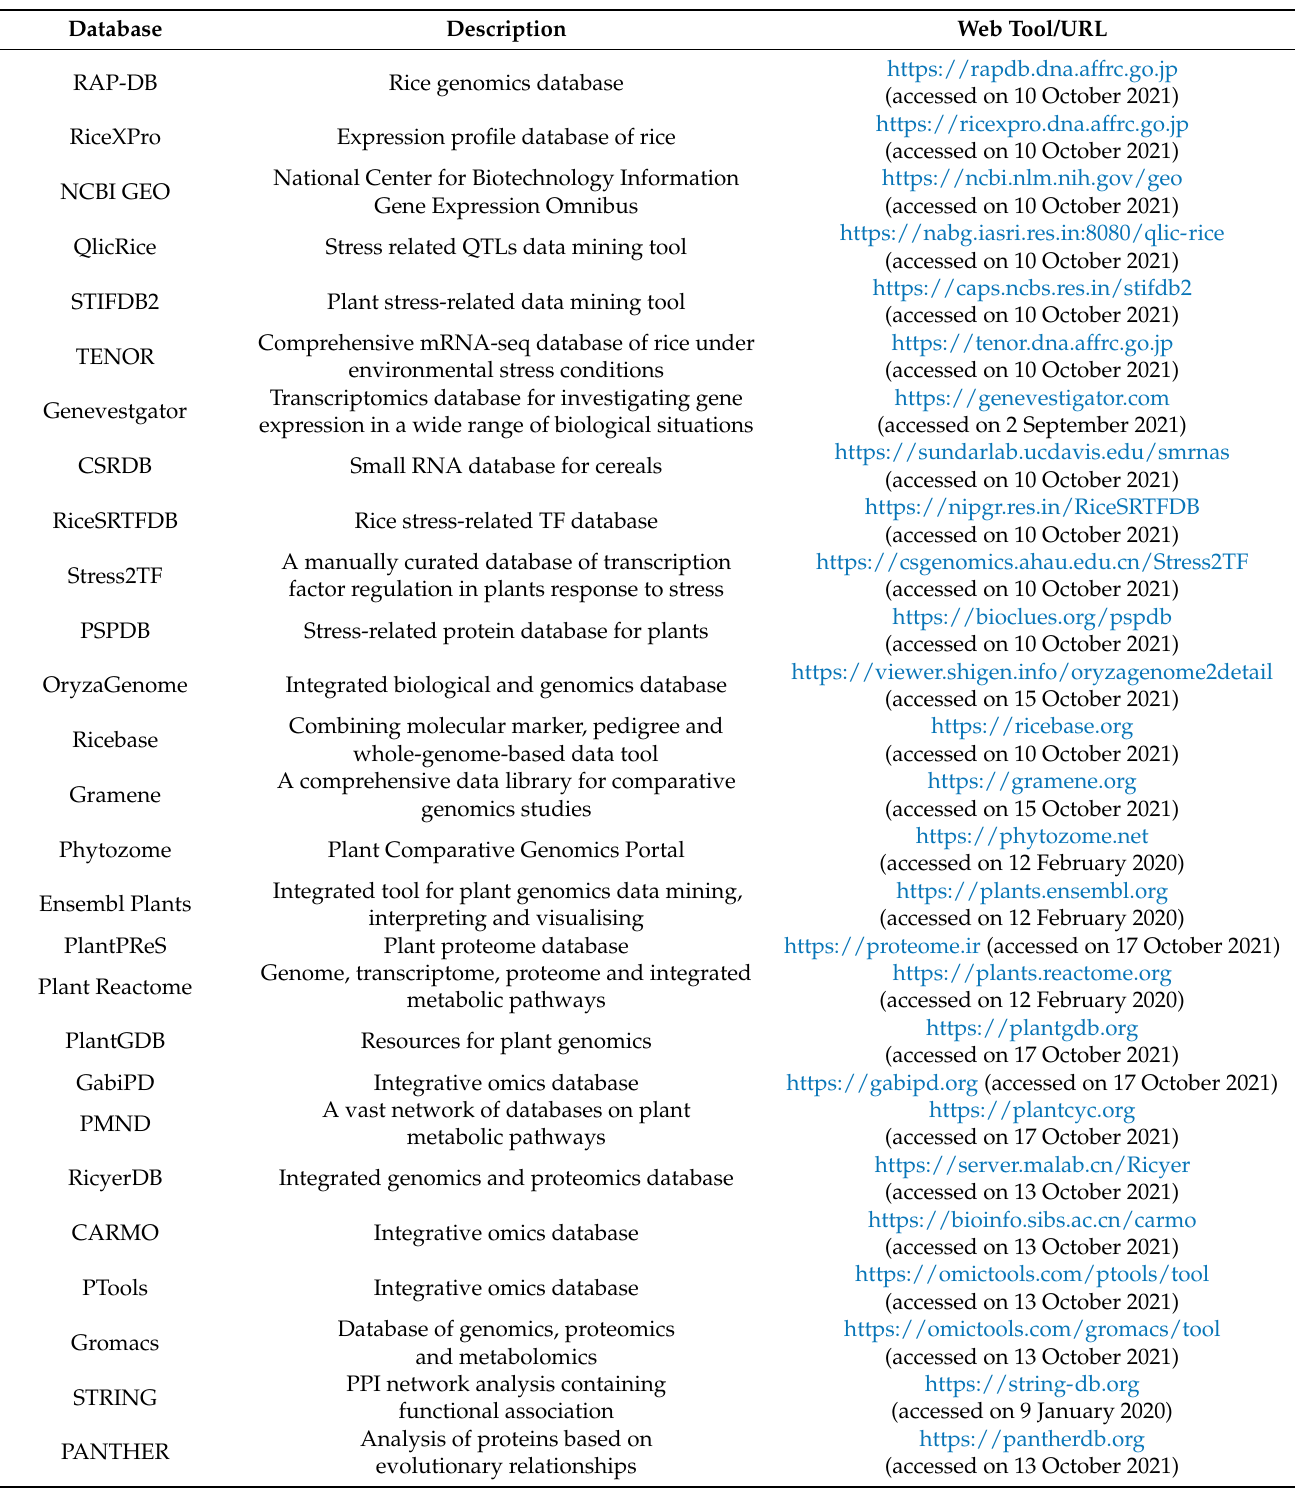
Table 3. Online databases available for rice integrated omics